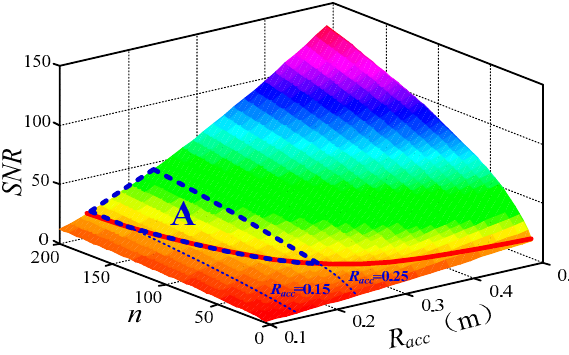
Figure 7. Contour map of signal-to-noise ratio (SNR) versus R acc and n.